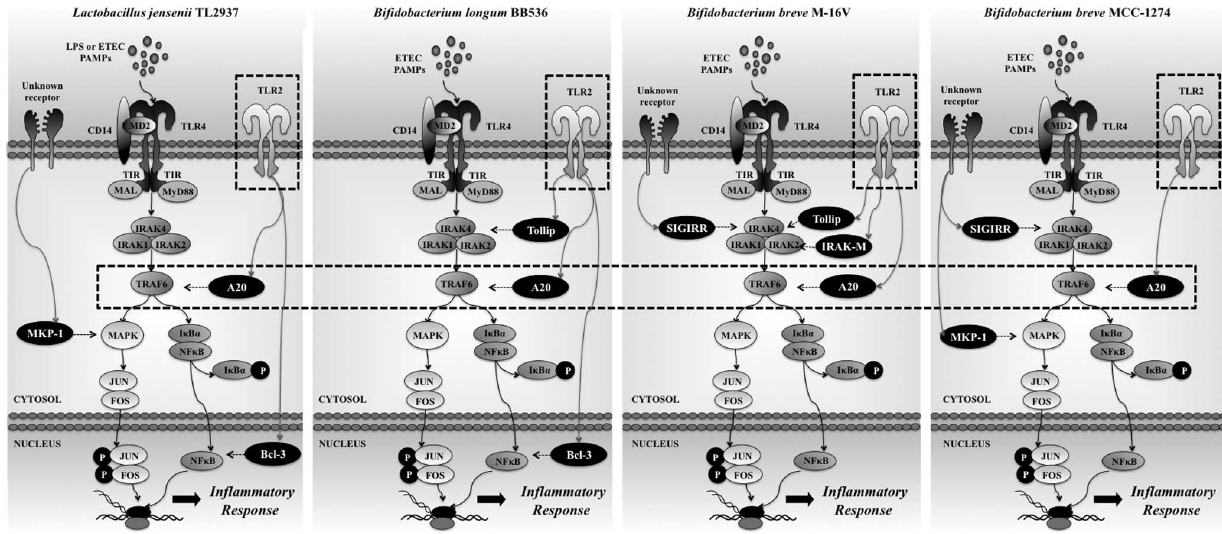
Figure 7. Proposed mechanism for the immunomodulatory effect of Bifidobacteriumlongum BB536 and Bifidobacteriumbreve M-16V in porcine intestinal epithelial cells. The effect of bifidobacteria strains is compared with the previously studied immunobiotic strain, Lactobacillus jensenii TL2937 [2].